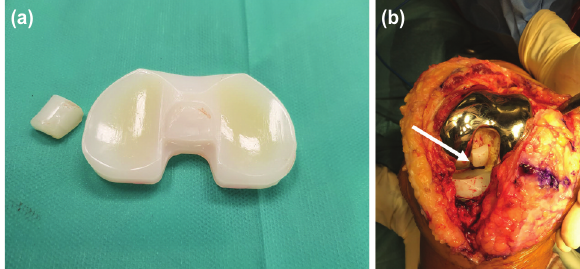
(a) Fracture of the tibial post at its base. (b) Intra-operative Fig. 2: image of the broken post in the femoral notch, denoted by the white